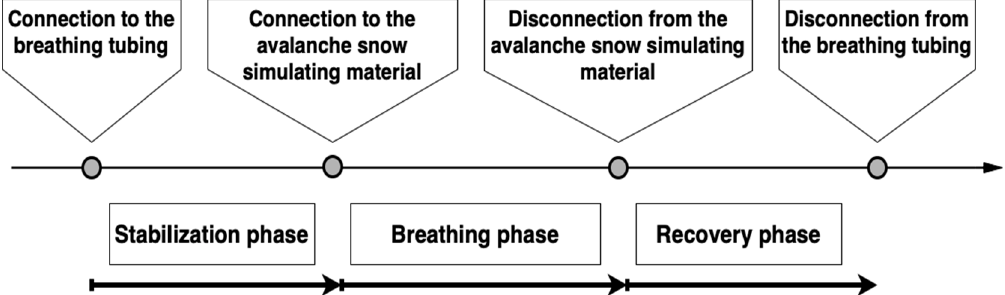
Figure 1. Phases of breathing experiments.